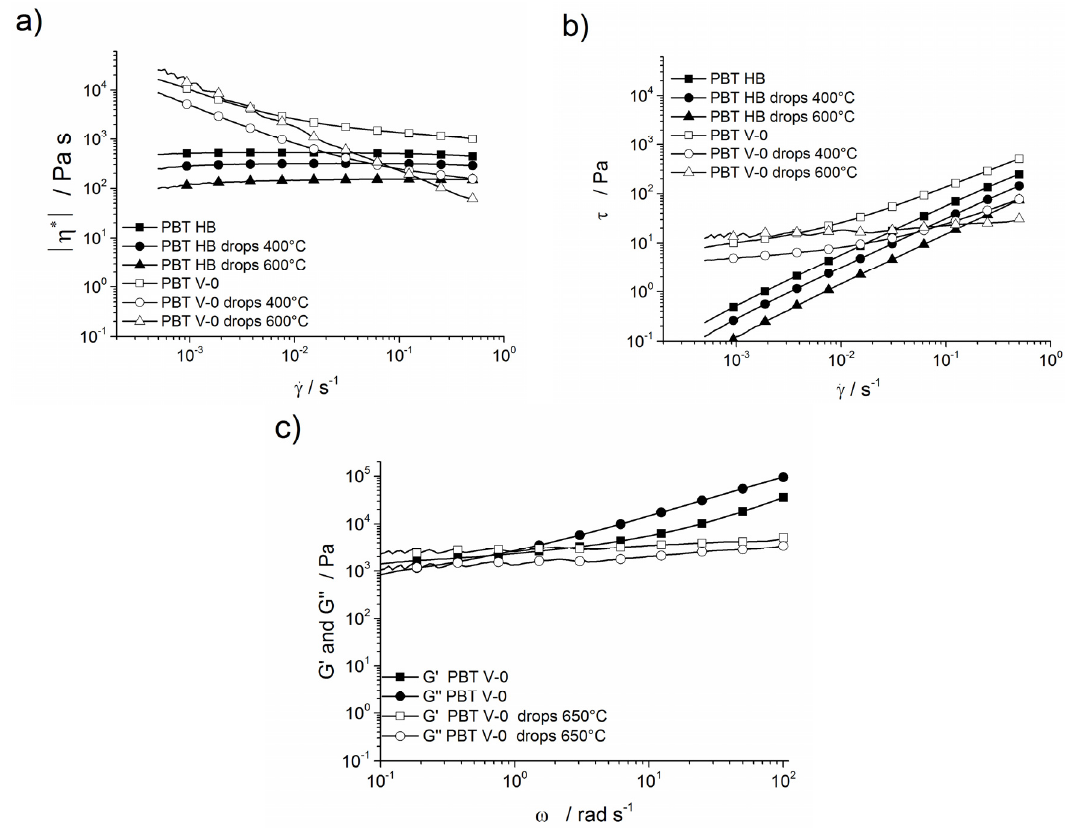
Figure 10. ( a ) Complex viscosity of PBT HB, PBT V-0 and their drops as a function of shear rate; ( b ) shear stress versus shear rate for PBT HB, PBT V-0 and its drops; and ( c ) storage modulus and loss modulus of PBT V-0 and its molten drops at 650 °C.